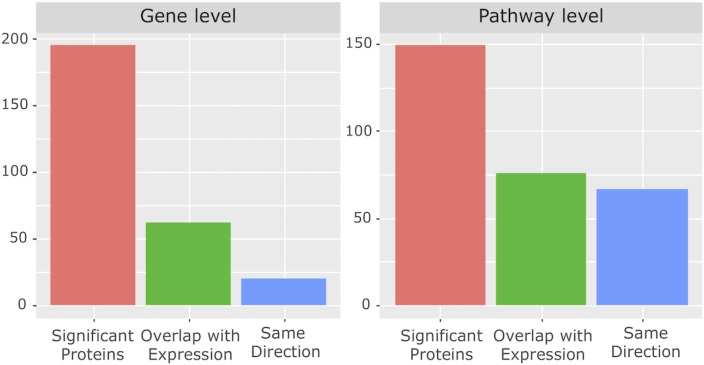
Overlap between proteomics and transcriptomics data at the gene and pathway levels.Proteomic level changes in RRMM compared to NDMM were evaluated against independent transcriptome data from the Multiple Myeloma Research Consortium reference collection. The graph shows the number of genes/proteins (left) or pathways (right) that are significantly different in the proteomics data (red bar), which also was significantly different in the transcriptome data (green bar), in the same direction (blue bar).